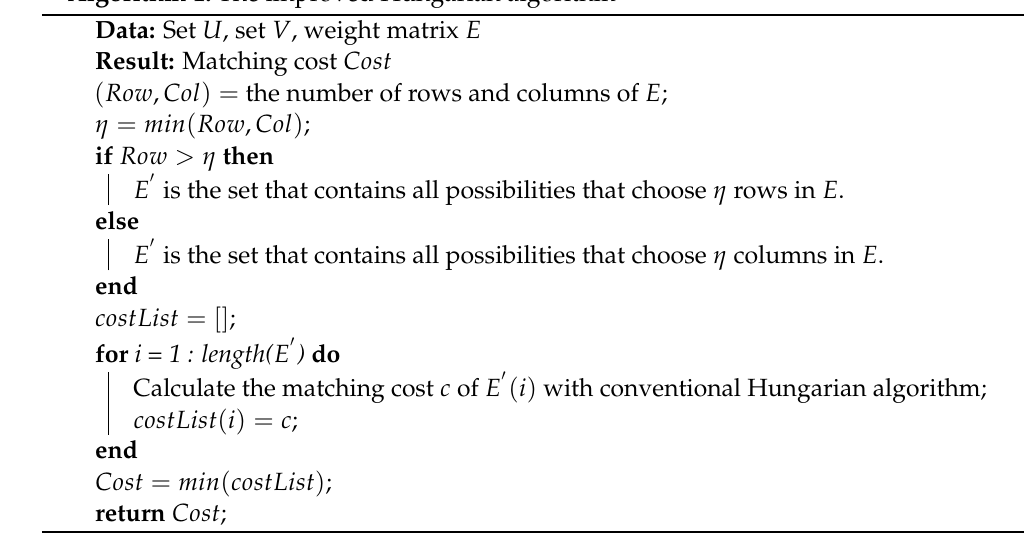
Algorithm 2: Calculating the match cost between two